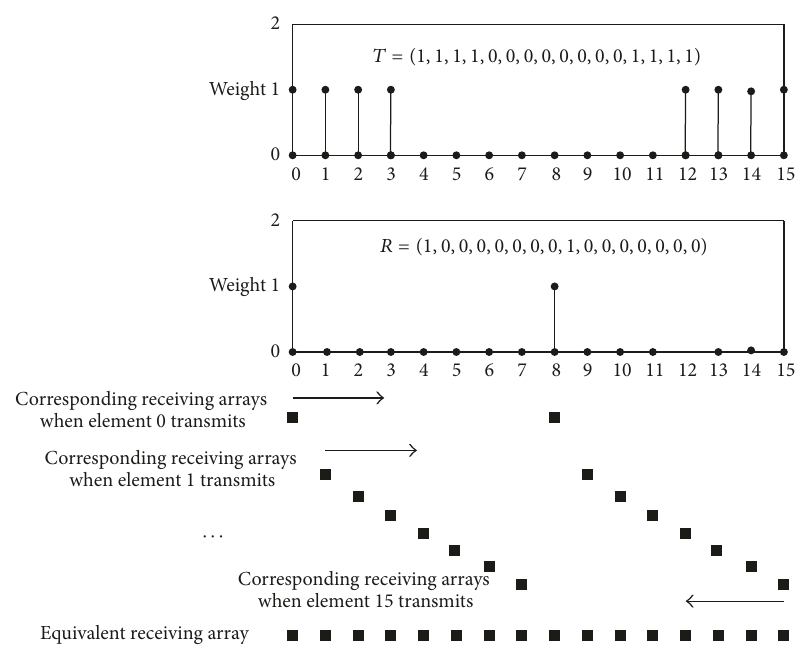
Figure 7: “8-transmitter 2-receiver” transmitter-receiver array and the equivalent receiving array.